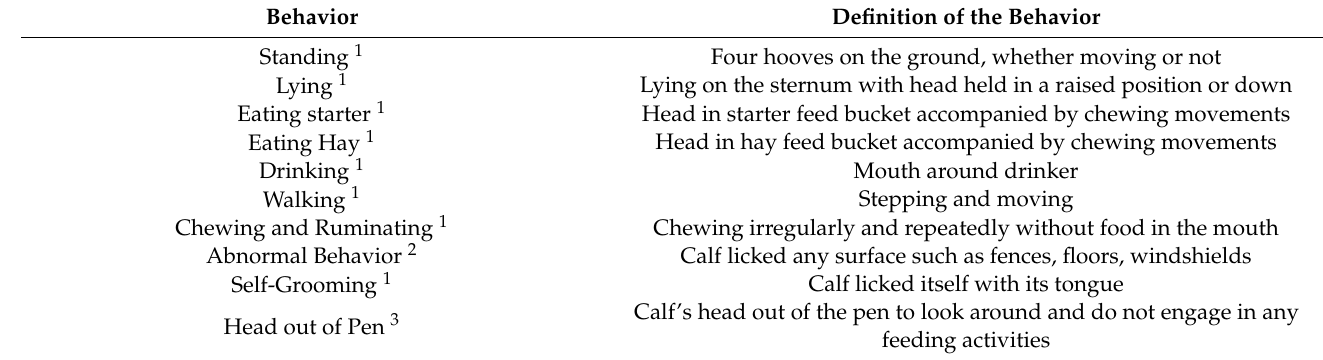
Table 8. Definitions of the examined